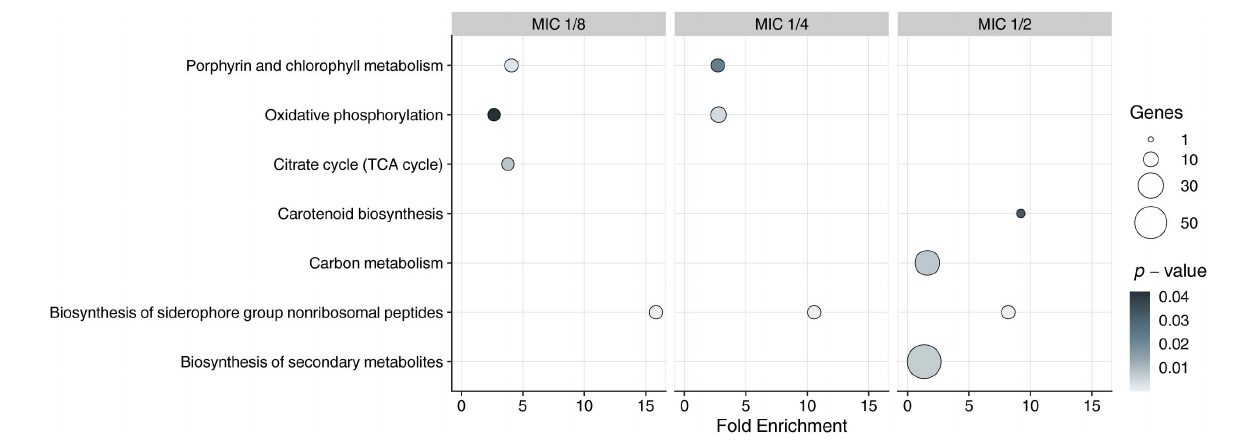
FIGURE 1 | Kyoto Encyclopedia ofGenes and Genomes enrichment analysis of DEGs in exposed to 3a samples with different MICs. Y -axis represents KEGG pathways, X -axis represents fold enrichment (amount of input pathway DEGs/background gene set, ≥ 1.5 considered as interesting). Dots colors represent the p -values of enrichment, the dots’ size represents the gene number in the